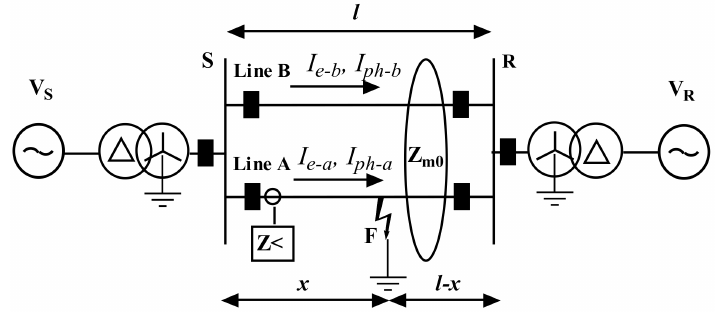
Figure 4. Parallel circuit fed from both